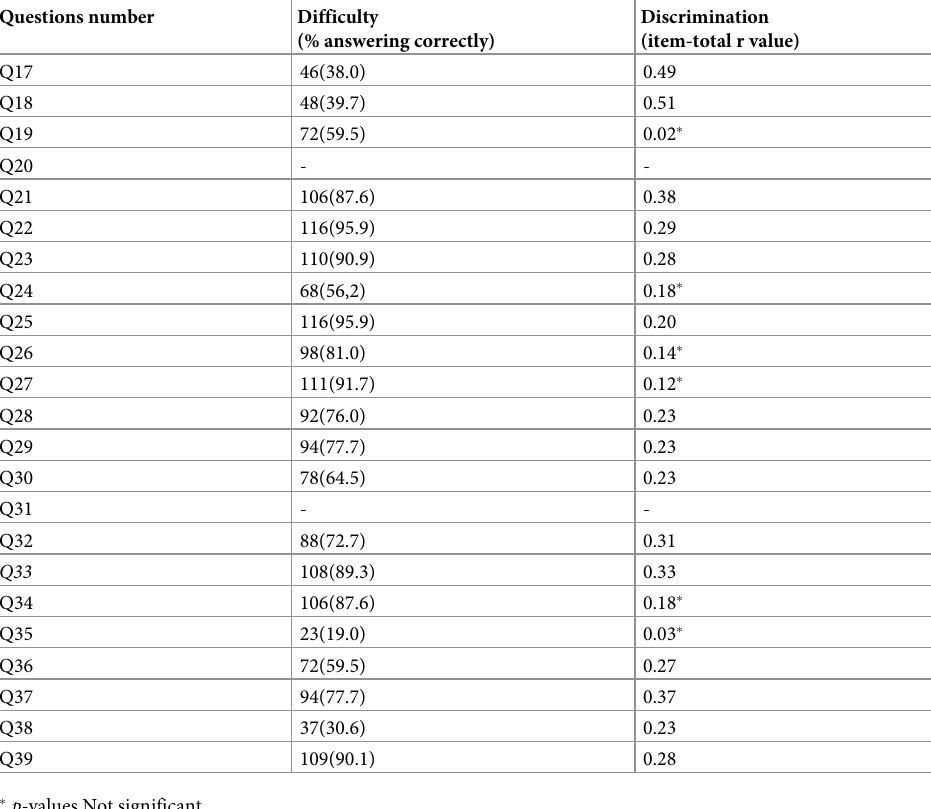
Table 4. Item difficulty and